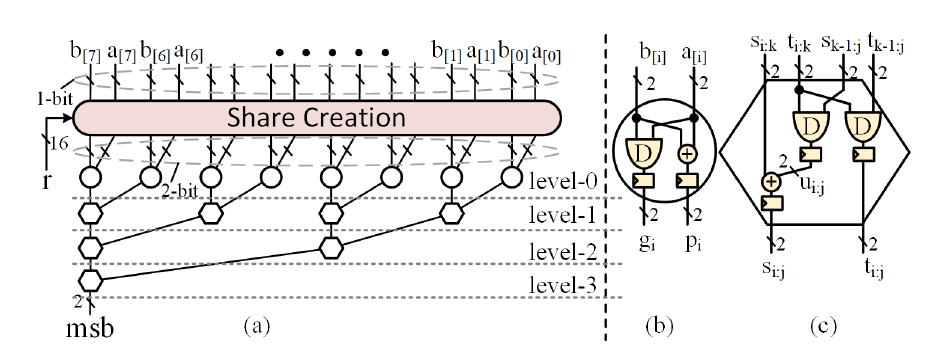
Figure 9: Hardware design of the masked activation function. A logarithmic carry chain propagates the carry using generate and propagate functions. AND gates are replaced with DOM-indep AND labeled as ‘D’; we omit the masks in the figure to avoid clutter. that gets multiplied by the secret ( w i,j ), it cannot create a hypothesis on the intermediate computations for a first-order side-channel